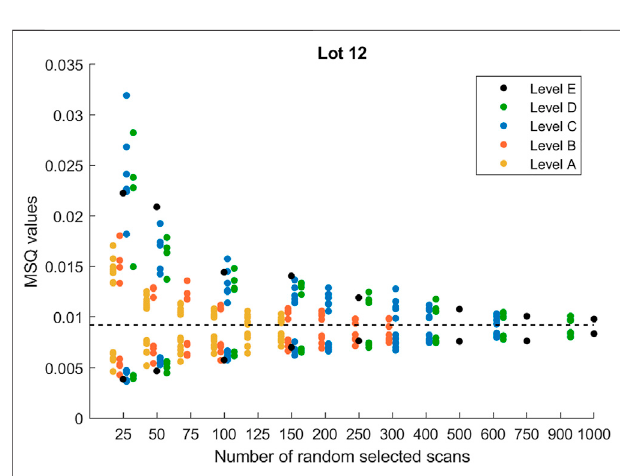
FIGURE 7 | Variability in the MSQ values of nested analysis of variance changingthenumberofrandomlyselectedscansandthenumberofsubsamples. Thedottedhorizontalblacklinerepresentstheestimatedoverallvariabilityoflot12. LevelA,eachsubsampleandreplicatearerepresentedequally;levelB,each subsample is represented equally; level C, groups of two subsamples are represented equally; level D, groups of three subsamples are represented equally; level E scans are selected freely among all subsamples and replicates. For a detailed description of the different levels, please refer to Figure 1B .